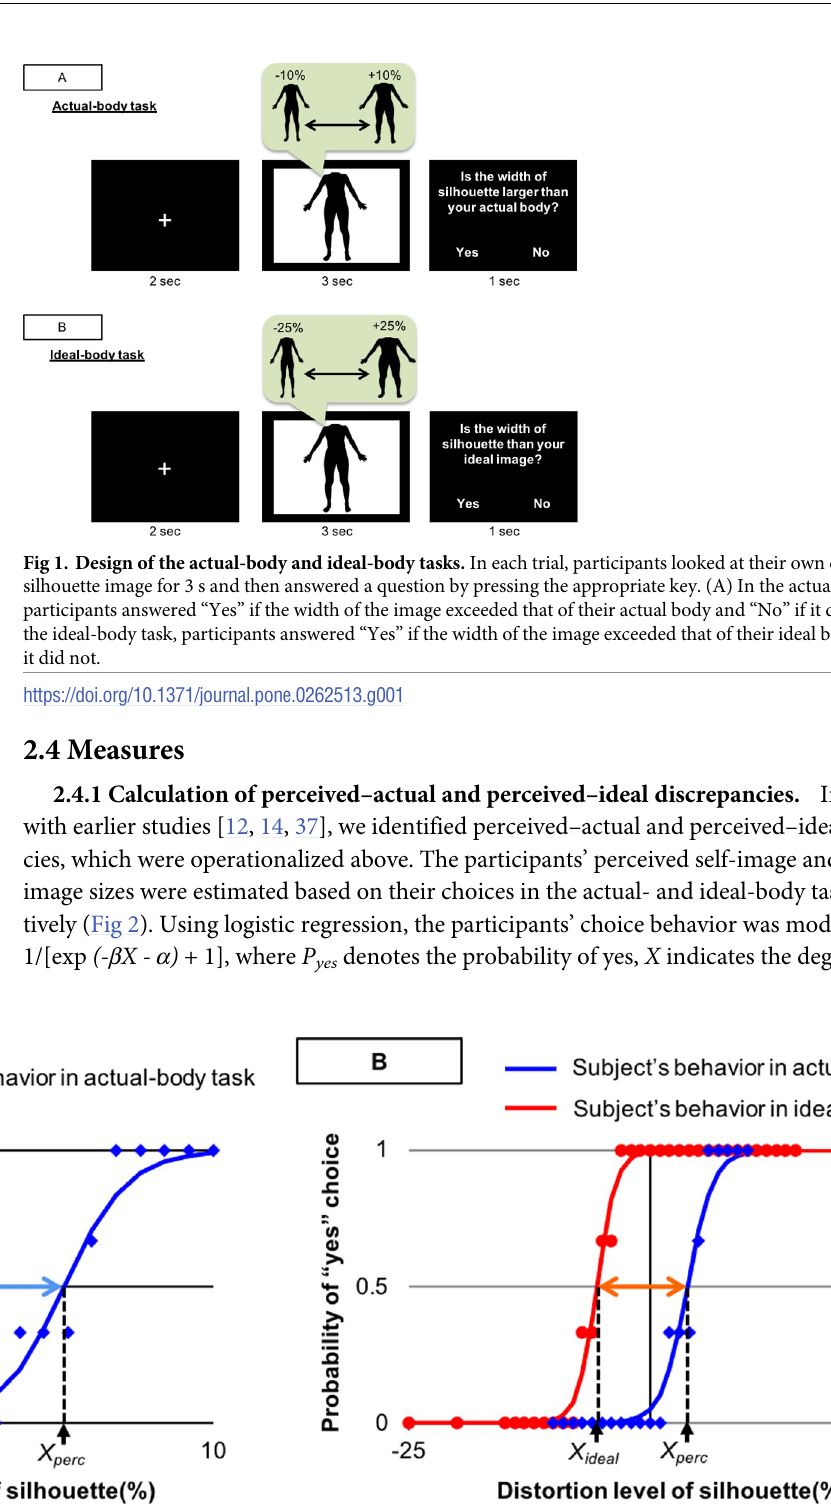
Fig 2. Procedure for estimating perceived–actual discrepancy and perceived–ideal discrepancy. A representative example of a participant’s behavior during the actual- body (blue line) and ideal-body (red line) tasks according to logistic regression modeling. (A) The right blue arrow represents the perceived–actual discrepancy, defined as a probability of choosing ‘Yes’ on the actual-body task of 0.5 (X ). (B) The orange arrow represents the perceived–ideal discrepancy, defined as the discrepancy between perc a probability of choosing ‘Yes’ on the actual-body task of 0.5 ( X perc ) and that on the ideal-body task ( X ideal ).